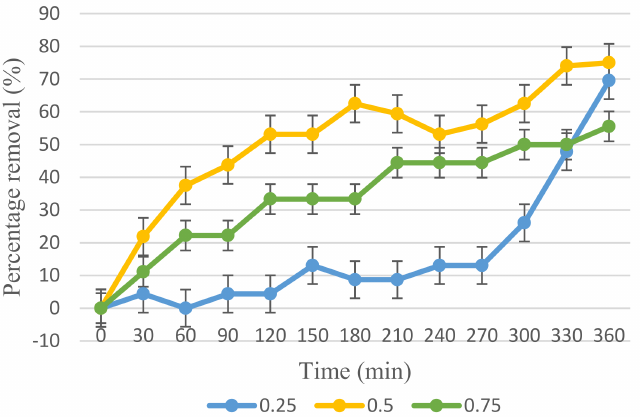
Figure 10. 10 mg/L of BPA removal by Cu 2 O/PVDF DLHF membranes at different Cu 2 O/PDVF ratios: 0.25, 0.50 and 0.75 under visible light